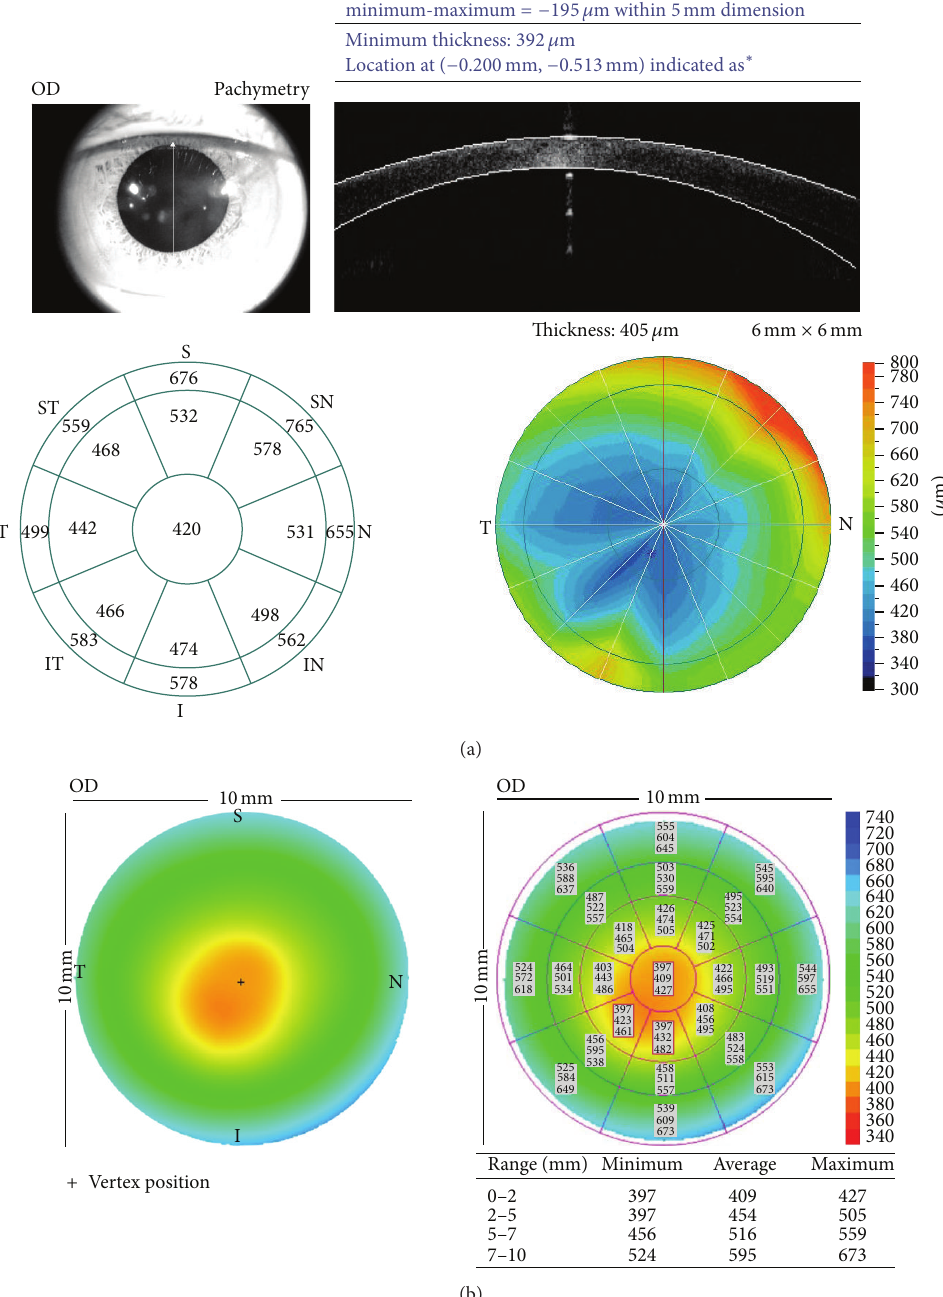
Figure 1: Corneal pachymetry of a patient with keratoconus generated by the (a) RTVue-OCT and (b) Visante-OCT. (a) Minimum of corneal thickness can be acquired from the table of “keratoconus analysis” on the upper right and the thinnest point is also marked on the pachymetric map on the lower right. A real-time monitoring on the upper left is used for pupil centering. (b) Minimum of corneal thickness in different regions is demonstrated on the table on the lower right and the thinnest point is also marked on the pachymetric map on the